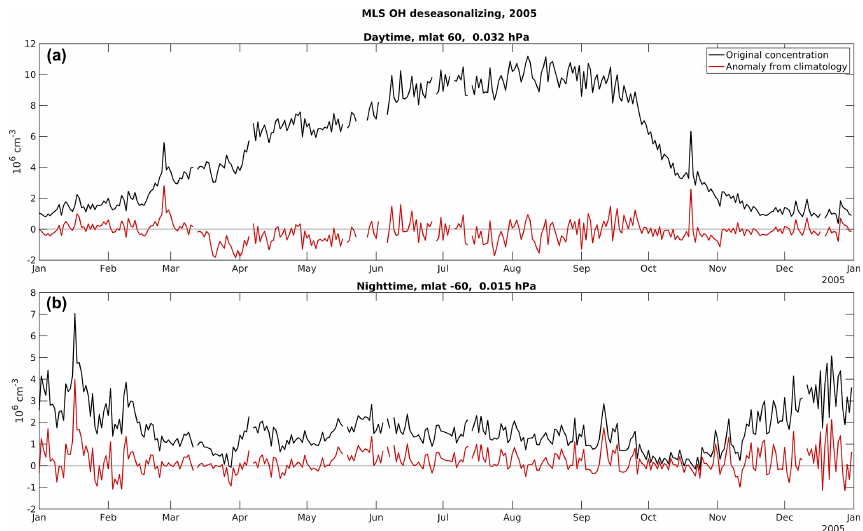
Figure 2. Daily MLS OH concentrations (in black) and the deseasonalized anomalies from the climatology (red) in 2005. Daytime (a) on magnetic latitude 60 ◦ N at 0.032hPa and nighttime (b) on magnetic latitude 60 ◦ S at 0.015hPa.